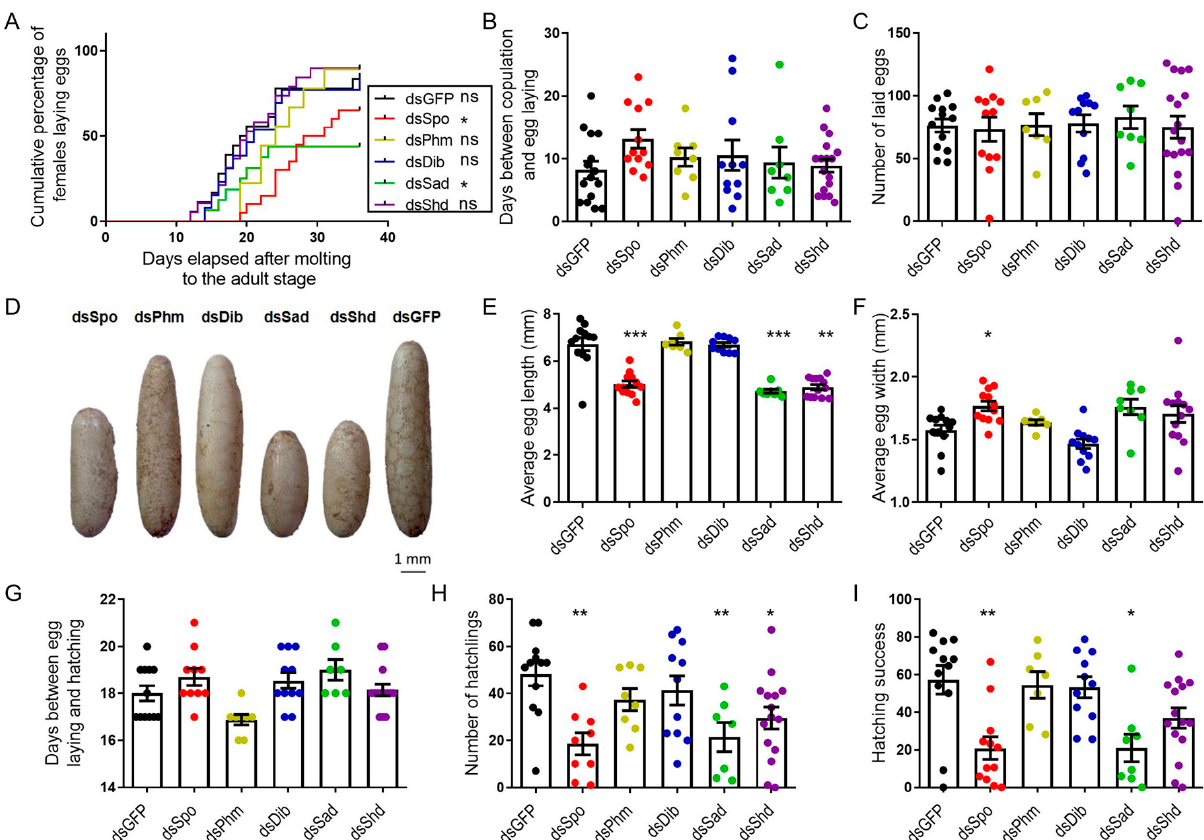
Figure 3. Effects of RNAi-mediated knockdown of the individual Halloween genes ( SchgrSpo , Schgr- Phm , SchgrDib , SchgrSad and SchgrShd ) on egg size, egg laying and hatching of adult female S. gregaria . ( A ) Cumulative percentage of egg laying by dsRNA-injected female locusts: 65.00% ( n = 12) for dsSpo -, 88.89% ( n = 7) for dsPhm -, 84.62% ( n = 11) for dsDib -, 50.00% ( n = 8) for dsSad -, 89.47% ( n = 13) for dsShd - and 83.33% ( n = 12) for dsGFP -treated females. The curves of dsSpo - and dsSad -treated females significantly differ from the curve of dsGFP -treated females ( p = 0.0335 and p = 0.0448, respectively; Mantel–Cox test) (* p < 0.05, ns = ‘not significant’). ( B ) The number of days between copulation